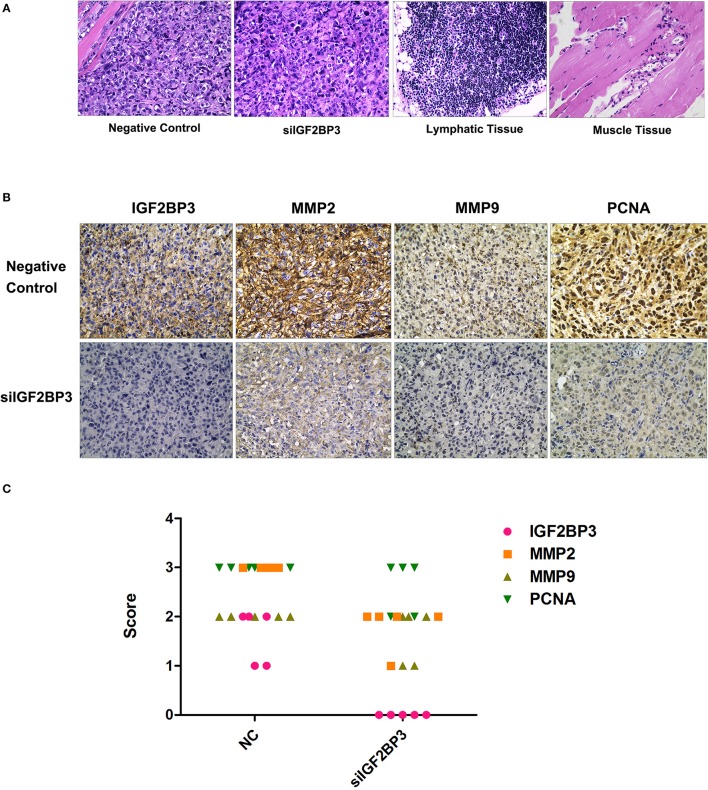
H&E and Immunohistochemistry staining for formalin-fixed paraffin-embedded tumor sections. (A) Neoplasm in negative controls has invaded and destroyed the basic structure of adjacent smooth muscle. There was no lymph node metastasis. (B) Expression levels of IGF2BP3, MMP2, MMP9, and PCNA in tissue blocks. Cancer cell cytoplasm staining was positive IGF2BP3, MMP2, and MMP9 were expressed in both membrane and cytoplasm while only nuclear staining was considered PCNA-positive. (C) Immunohistochemical scores were authorized by two pathologists under strictly double-blind method: the percentage and intensity of immunoreactive cancer cells <5% (score 0), 5~25% (score 1), 26~50% (score 2), 50~75% (score 3), and >75% (score 4).